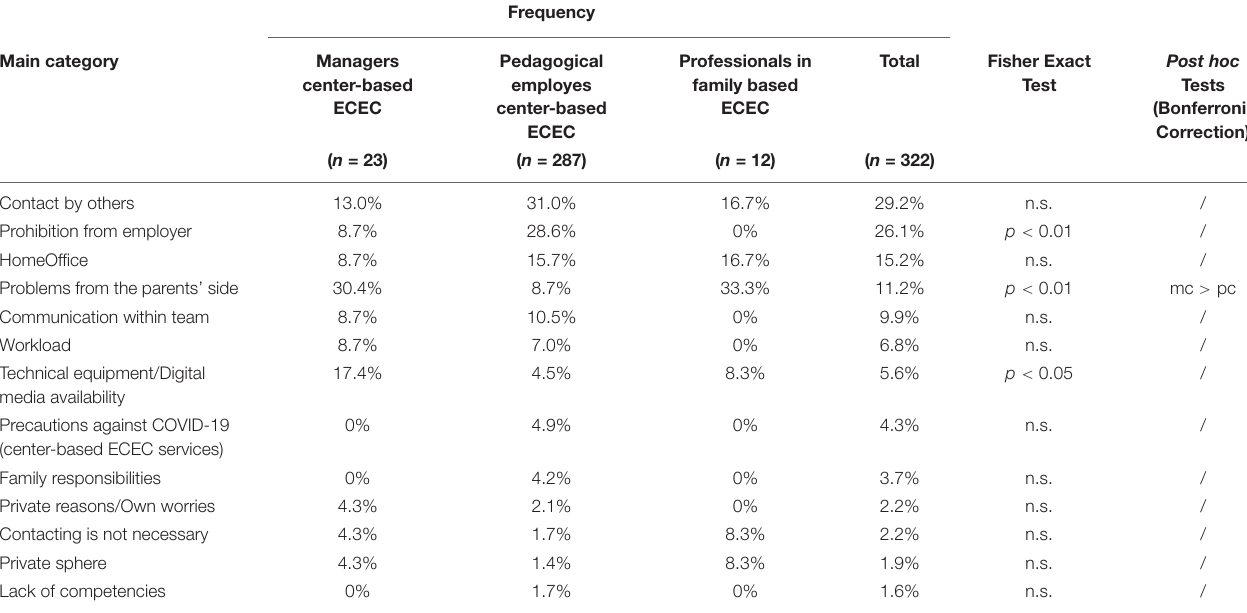
TABLE 5 | Main categories and their respective frequencies of reasons for not being in contact with parents ( n = 322).